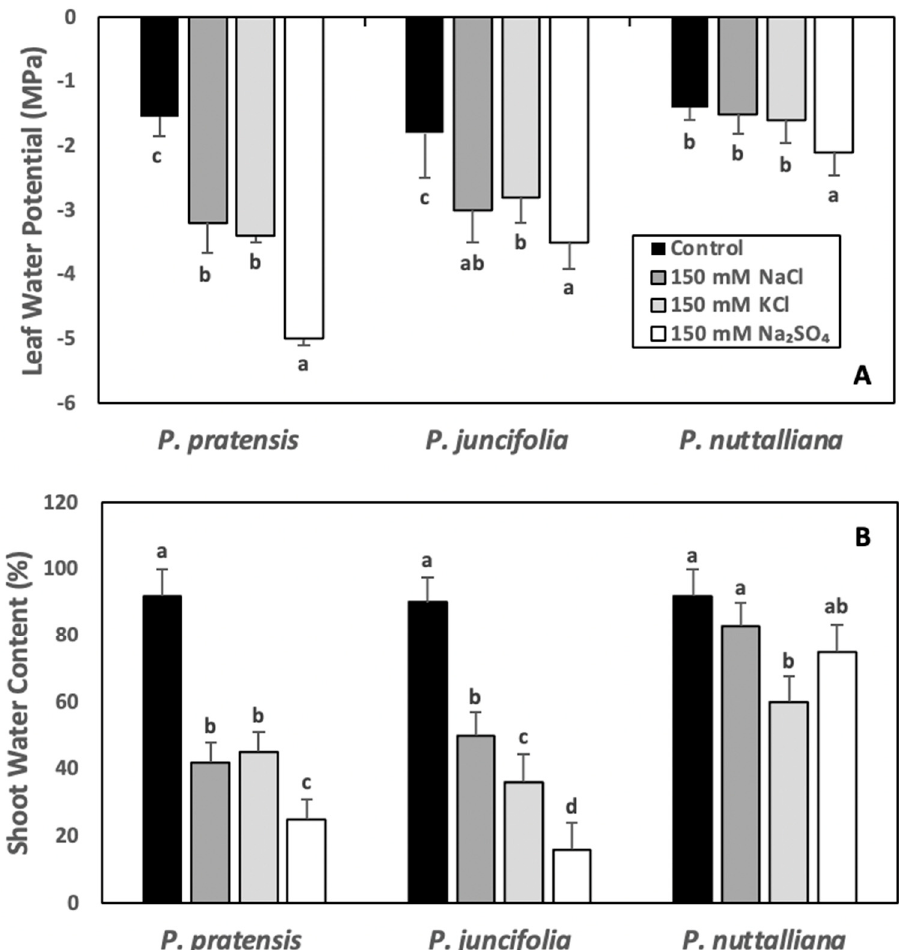
Figure 4. Leaf water potentials ( A ) and shoot water contents ( B ) in Poa pratensis , Poa juncifolia , and Puccinellia nuttalliana treated with 150 mM NaCl, 150 mM KCl, and 150 mM Na 2 SO 4 and in untreated control plants. The measurements of leaf water potentials were carried out after six days and shoot water potentials after ten days of treatments. Different letters above the bars indicate significant differences ( p ≤ 0.05) between treatments within each as determined by the Tukey’s test. Means ( n = 6) and SE are shown.